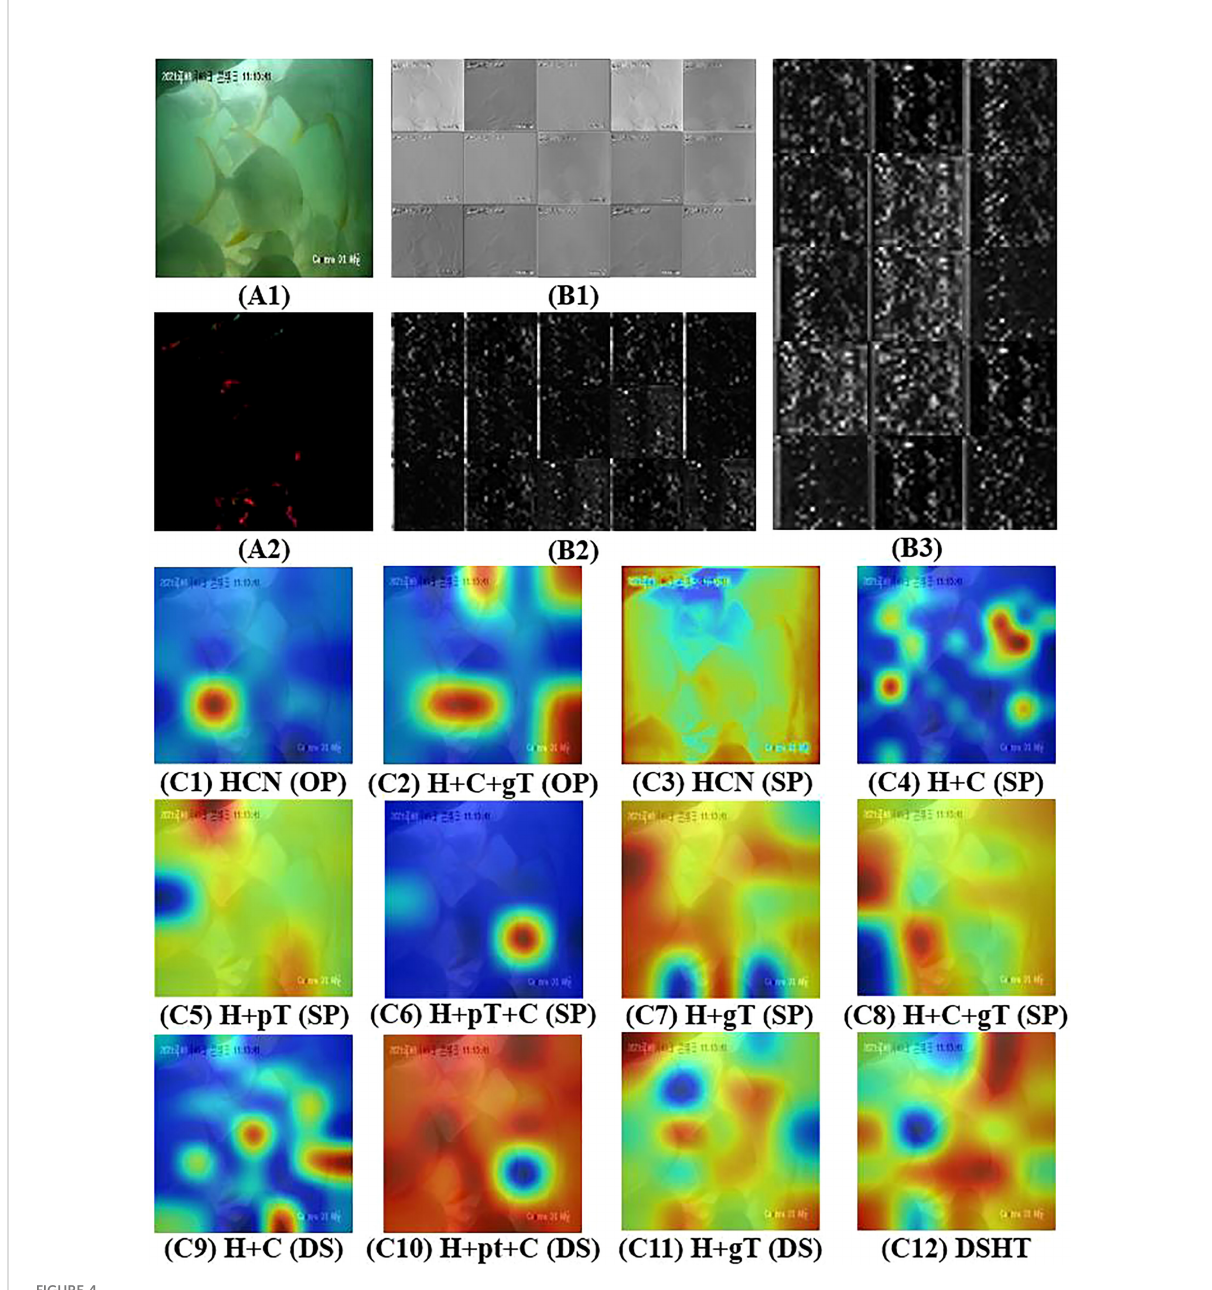
FIGURE 4 Visualization of Output Features. A1 is the spatial image which is fed into the spatial channel. A2 is the optical fl ow image which is fed into the temporal channle. B1 and B2 are DSHT ’ s hierarchical features in spatial and temporal channels, respectively. B3 is the output features of CFC in DSHT. From C1 to C12, respectively, they represent the Class Activation Map (CAM) of DSHT and other models mentioned in Ablation Experiments. H, C, gT, and pT are abbreviations for HCN, CFC, piecemeal Transformer, and global Transformer,